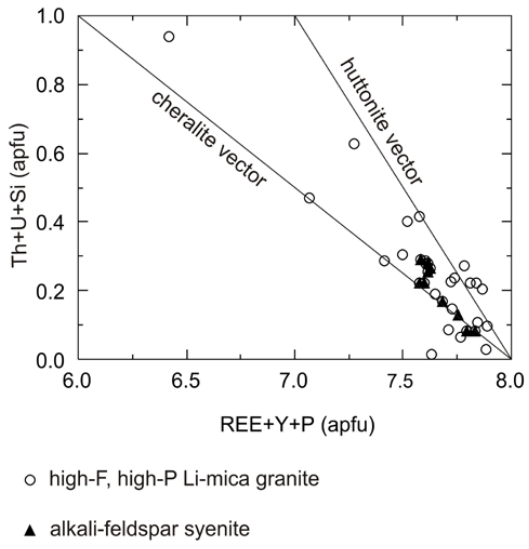
Figure 9. Xenotime composition vectors of xenotime from the Krudum granite body.